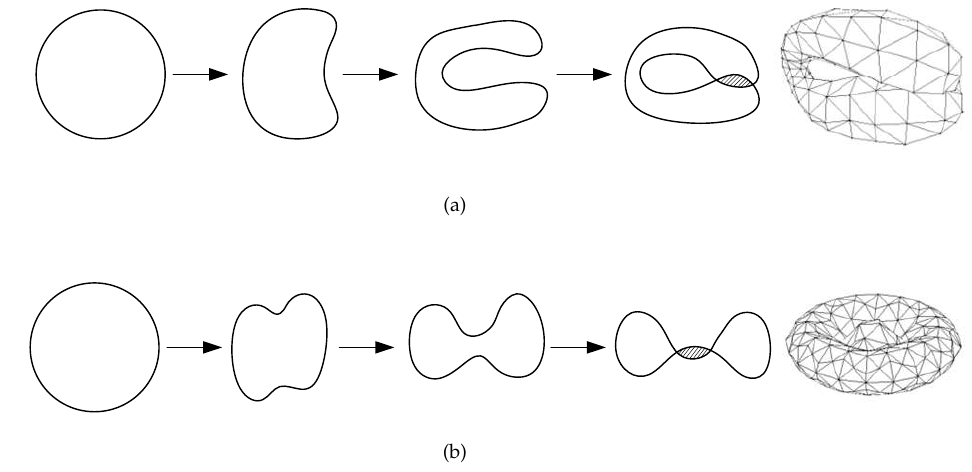
Figure 2. Two typical way of self-intersection: ( a ) Self-intersection due to interpenetration of the outer surface. ( b ) Self-intersection due to interpenetration of the inner